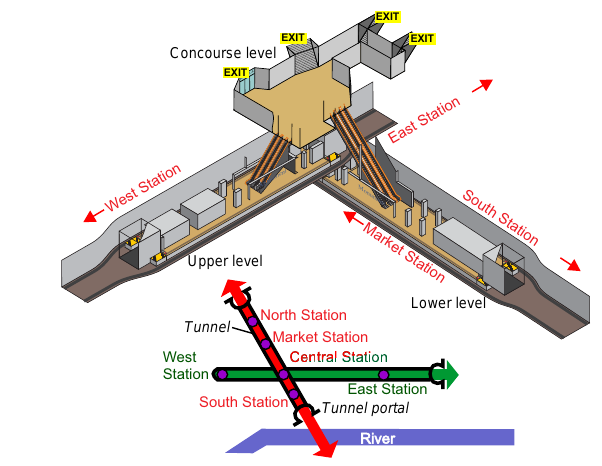
Figure 1. Three-dimensional view of Central Station and overview of underground stations of the subway system.